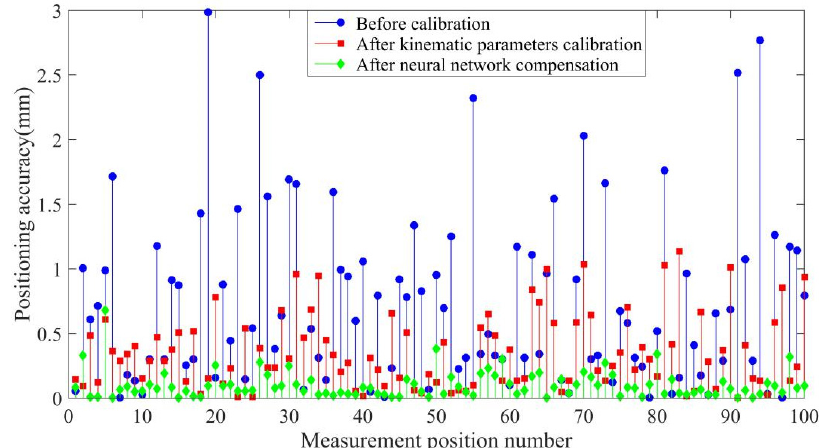
Figure 8. Positioning accuracy of the simulations.